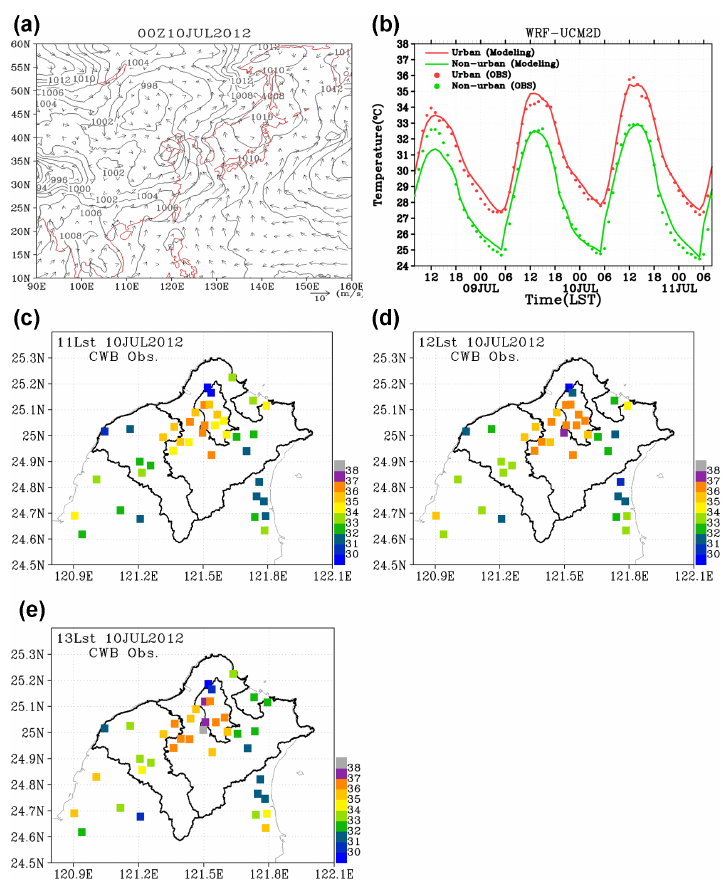
Figure 3. Panel (a) : surface weather map at 08:00LST, 10 July 2012. Panel (b) : mean hourly air temperature simulated by WRF–UCM2D and observed at 19 urban stations and 21 non-urban stations (red dots and yellow dots, respectively, in Fig. 1c) during the study period. Spatial distribution of air temperature observed at (c) 11:00LST, (d) 12:00LST, and (e) 13:00LST on 10 July 2012 at various meteorological stations. Unit is degrees